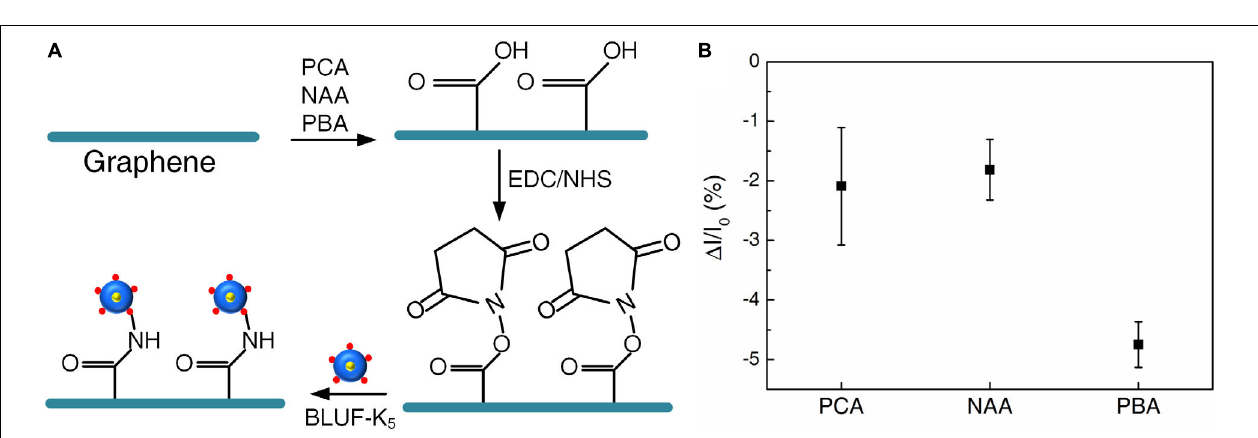
FIGURE 1 | Fabrication and characterization of the graphene field effect transistor. (A) The schematic representation of the pristine graphene substrate. (B) The Raman spectrum of pristine graphene.